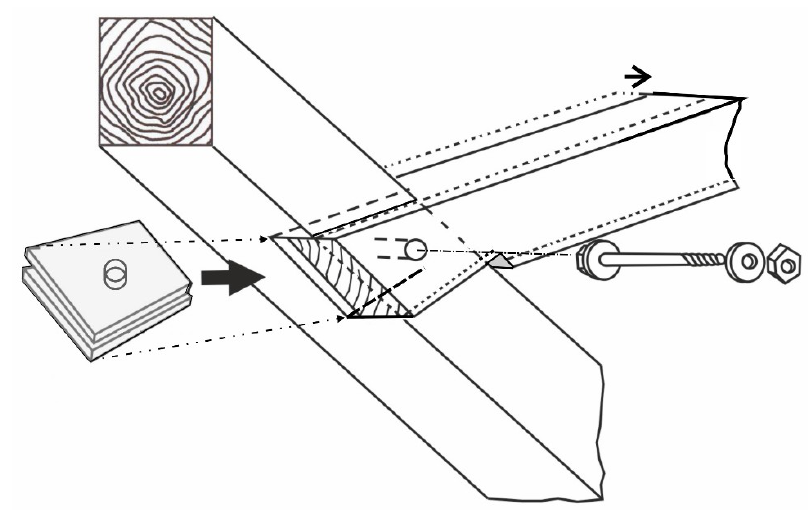
Figure 4. Schematic sketch showing insertion of friction plates into a halved dovetail joint, without complete dismantling, which is the main advantage of this approach.